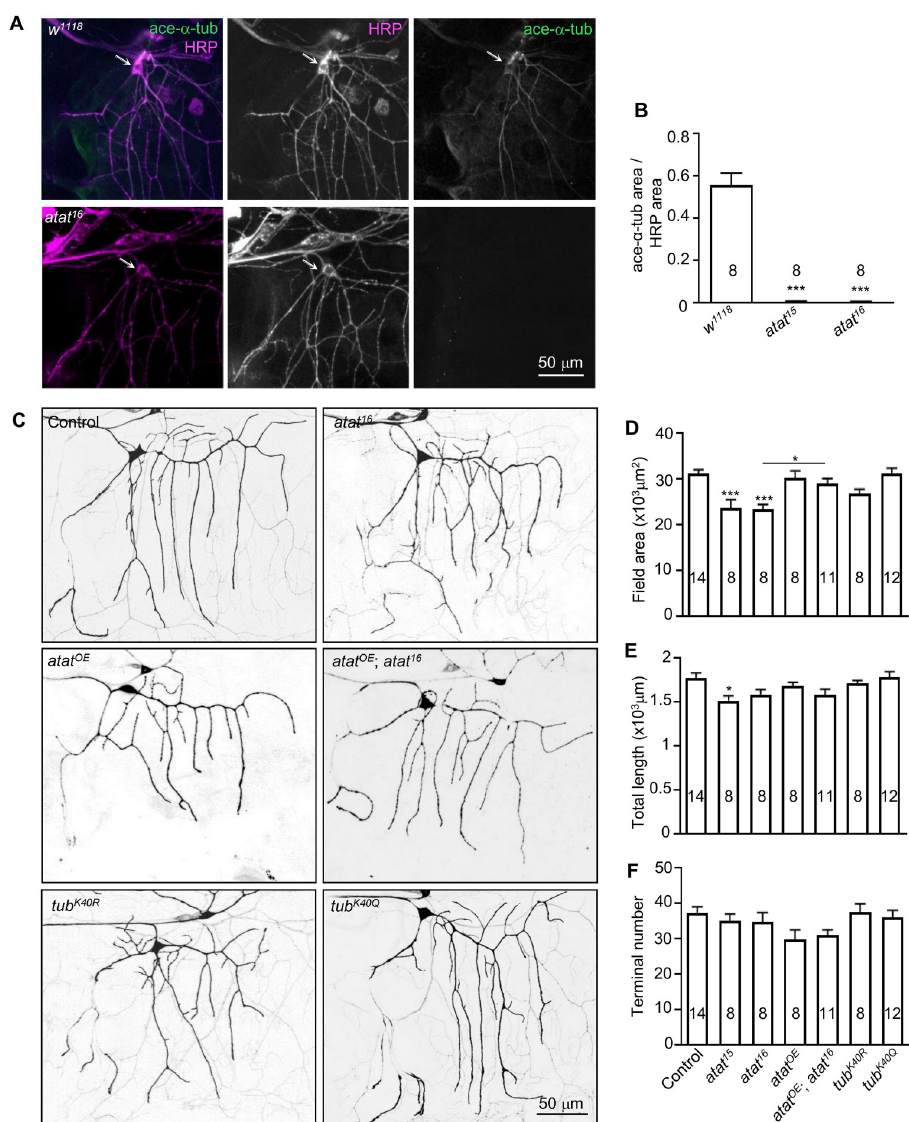
Fig 4. Acetylated α -tubulin is required for dendritic arborization of class I da sensory neurons. (A) Class I da neurons in both control ( w 1118 ) and atat 16 mutant were stained with anti-acetylated tubulin (green) and anti-HRP (magenta, labels neuronal membranes). (B) Quantification of acetylated microtubule levels in wild type and two atat mutants. Mean ± SEM. One-way ANOVA with Tukey’s multiple comparisons test. ��� p < 0.001. (C) Dendritic elaboration of class I da neurons labeled with mCD8-GFP under the control of 221-Gal4 . The genotypes are control ( 221-Gal4 > mCD8-GFP), atat 16 , Atat overexpression driven by 221-Gal4 ( atat OE ), Atat overexpression using 221-Gal4 in atat 16 mutant ( atat OE ; atat 16 ), α 1-tubulin K40R ( tub K40R ), and α 1-tubulin K40Q ( tub K40Q ). Scale bar: 50 μ m. (D–F) Quantification of dendritic field areas (D), the total dendritic lengths (E), and the numbers of dendritic termini (F). Mean ± SEM. One-way ANOVA with Tukey’s multiple comparisons test. ��� p < 0.001, � p < 0.01.